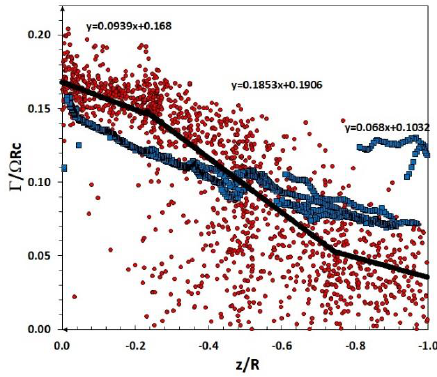
Figure 16. Non-dimensional net circulation. Comparison between the experiment (red) and the numerical simulation (blue). The black lines are the linear interpolation of the experimental data on three separate zones (0 ≥ z/R ≥ −0.23; −0.75 ≥ z/R ≥ −0.23; −0.75 ≥ z/R ≥ −1).